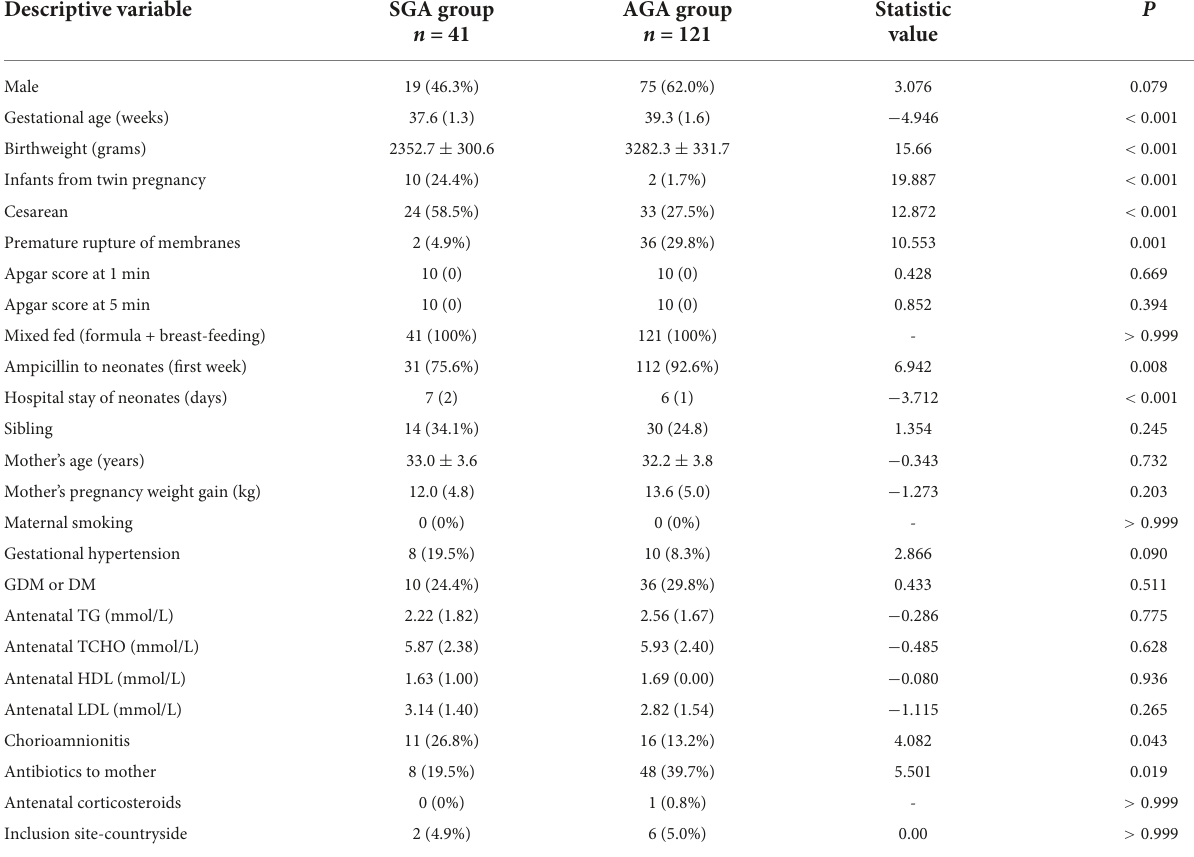
TABLE 1 Clinical characteristics of the SGA and AGA